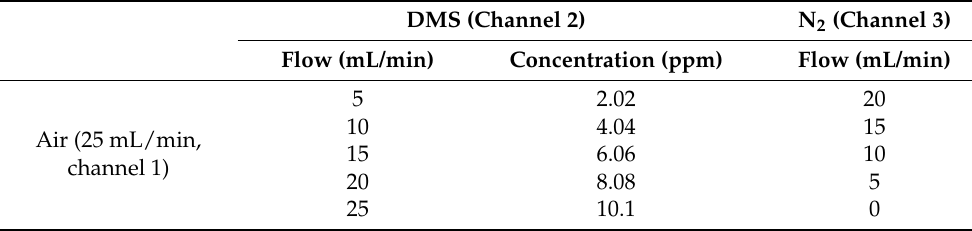
Table 2. The reference concentration settings of three gases in the first group.